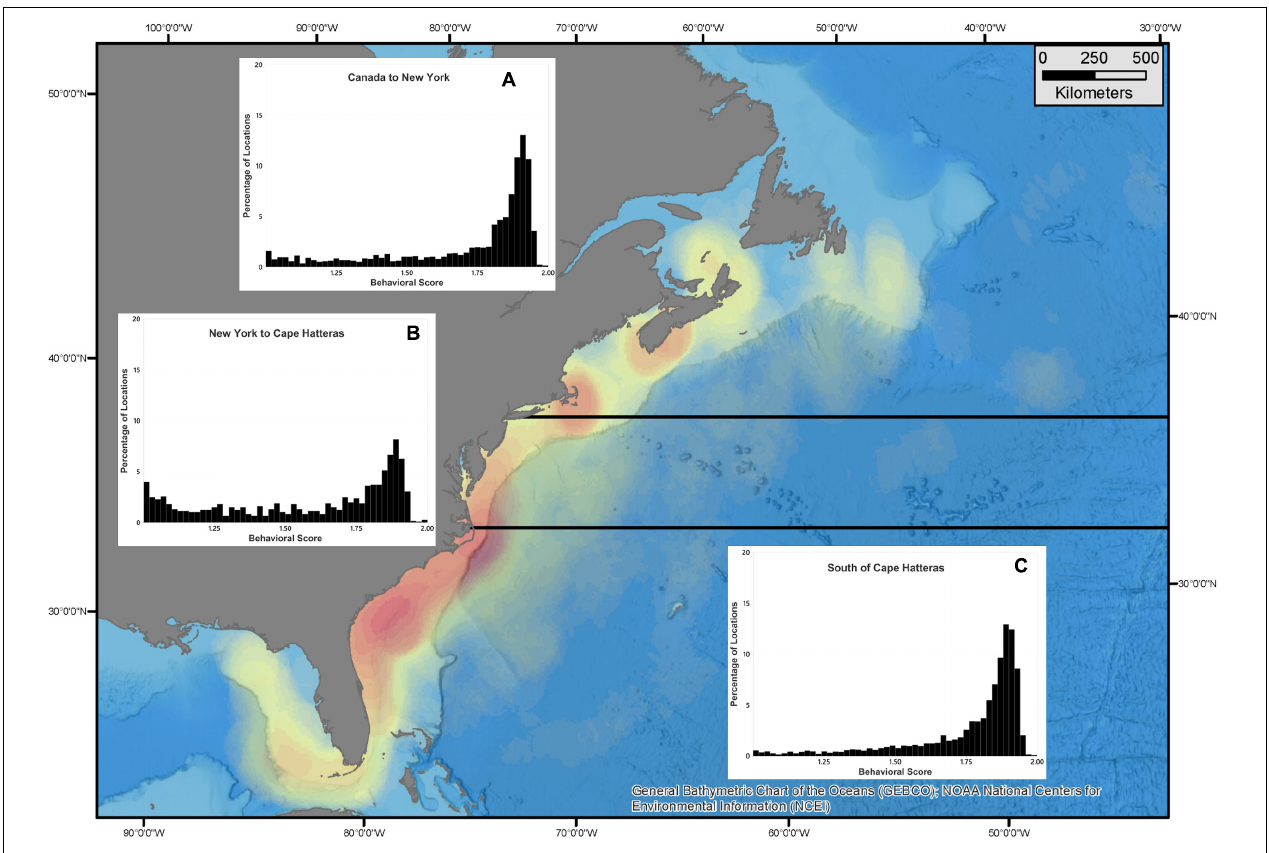
FIGURE 7 | Proportions of white shark locations across range of behavioral scores derived from the hSSM from each of three regions: North of Long Island, NY (A) ; south of Cape Hatteras, NC including the Gulf of Mexico (C) ; and the migration corridor between these two (B) . Utilizing hSSM-derived behavioral scores, behavior is classified as resident ( b = 1.75–2.00), transient ( b = 1.00–1.25), or unclassified ( b = 1.26–1.74) The basemap represents a simple point density of all daily locations. Three adult, female sharks with significant off-shelf locations were not